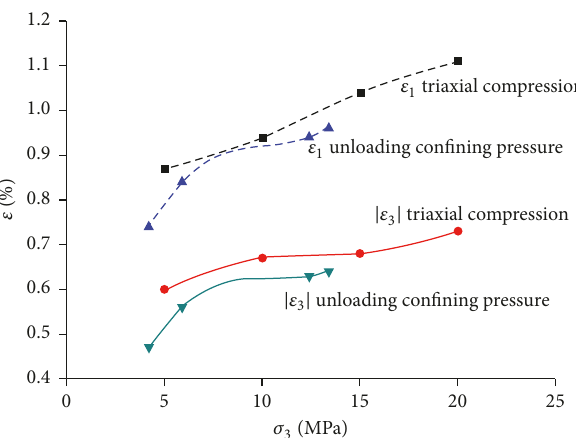
Figure 5: Axial strain and circumferential strains of stress peak value under different stress paths.